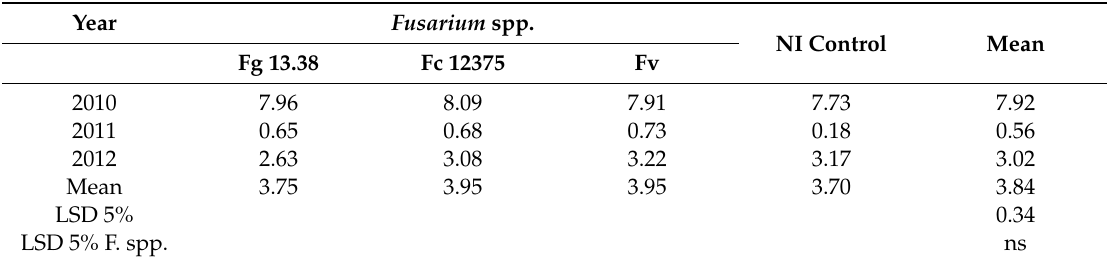
Table 8. Influence of years on the ear rot contamination caused by toxigenic fungi in maize hybrids, silk channel method, Szeged, 2010–2012.